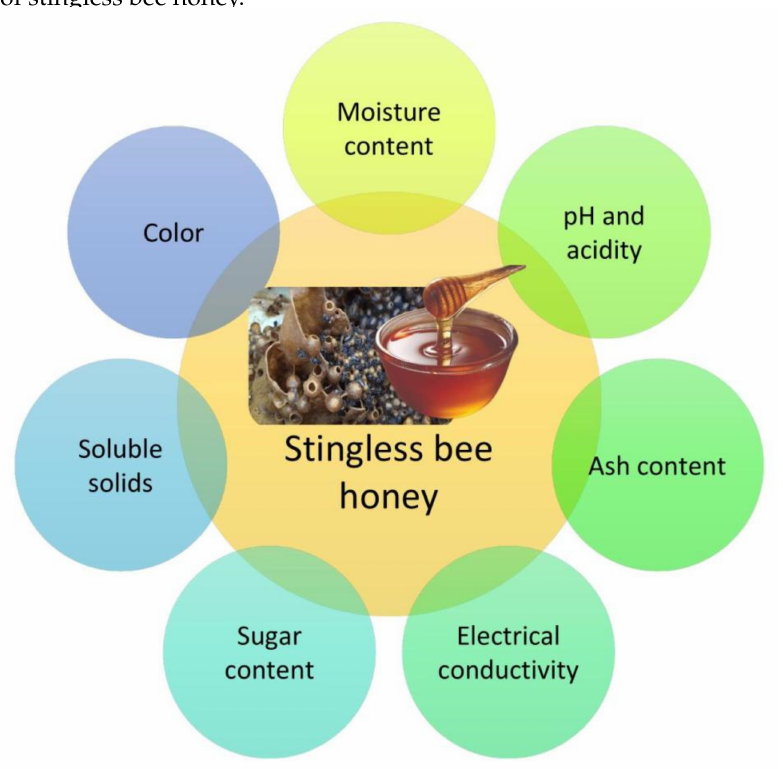
Figure 2. The important parameters for physicochemical properties of stingless bee